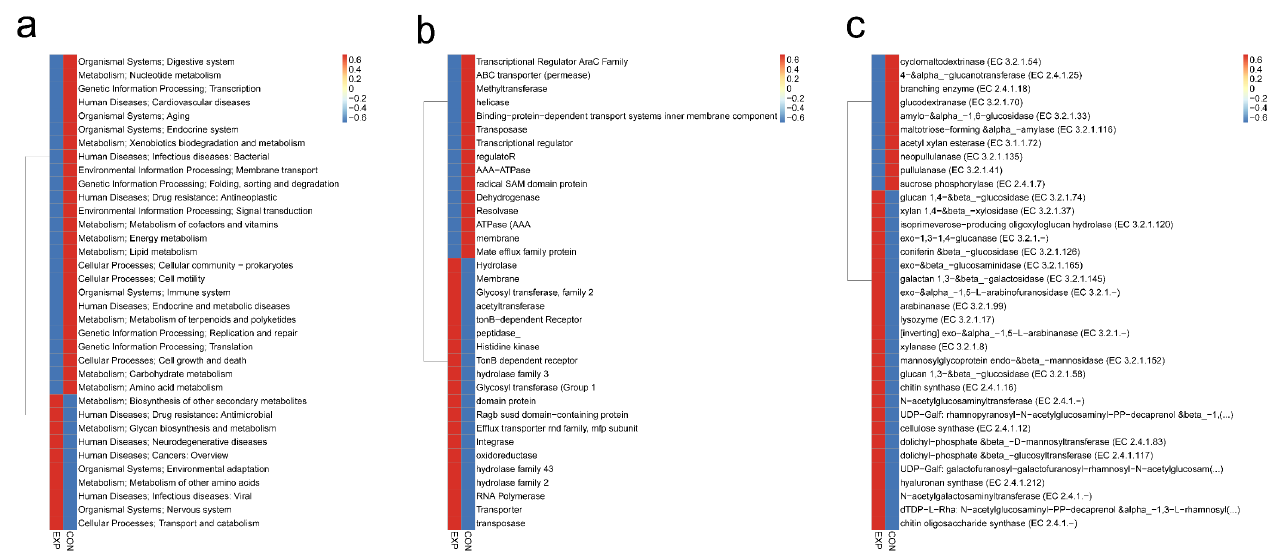
Figure 5. Functional characterization of gut microbiota (BLCA patients, EXP group; healthy indi- viduals, CON group). ( a ) Distributions of relative abundances of KEGG pathway categories in EXP and CON groups. ( b ) Distributions of relative abundances of eggNOG pathway categories in EXP and CON groups. ( c ) Distributions of relative abundances of CAZy pathway categories in EXP and CON groups.